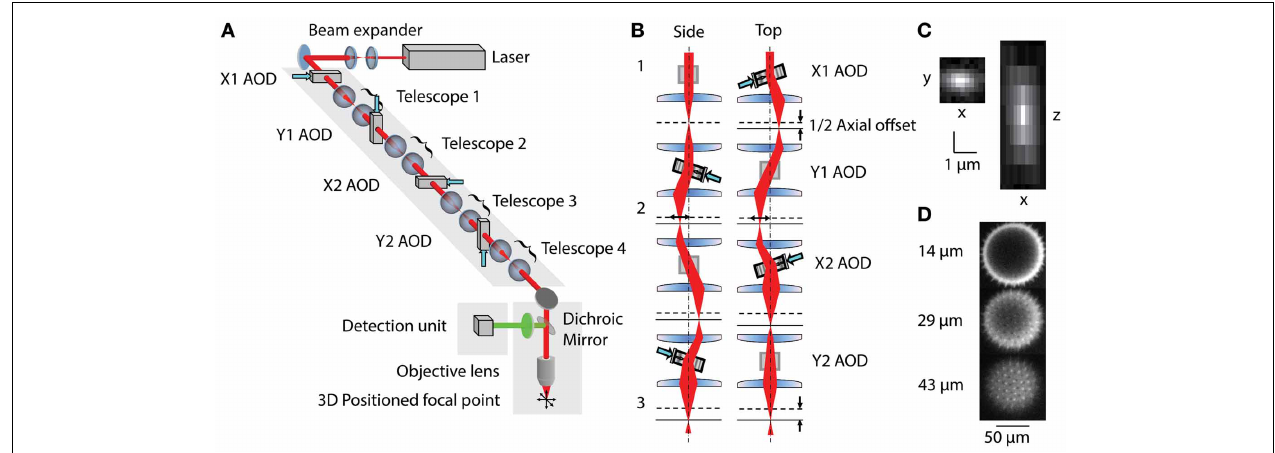
FIGURE 1 | (A) Layout of 3D-RAMP Microscope. The expanded beam of a pulsed Ti:S laser is shaped in its collimation and angle at the backfocal plane of the objective lens by a chain of 4 AODs and telescopes, resulting in 3D positioned focus. (B) Principle of controlling the axial position of the laser focus. For clarity, a side and a top view of the scanning unit are shown. The direction and frequency of the chirped sound waves at two pairs of AODs creates the desired focal